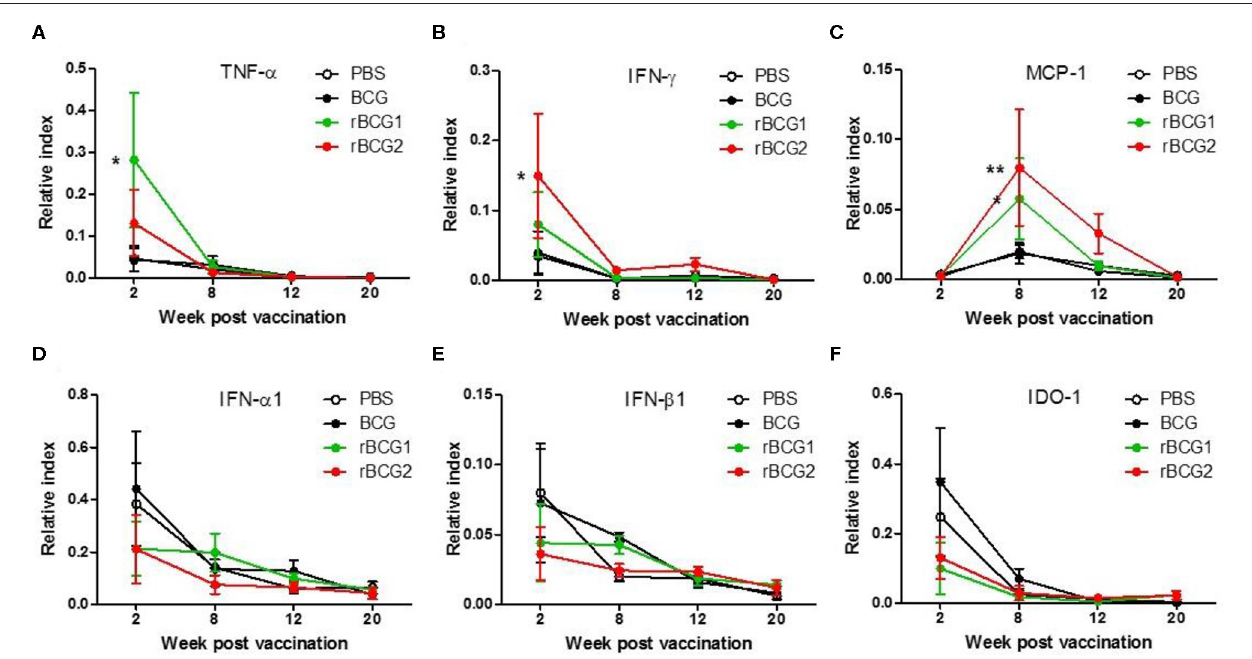
FIGURE 3 | Th1-mediated cytokine profiles expressed in murine lung following immunization with rBCG1 or rBCG2. C57BL/6 mice were immunized with BCG, rBCG1 or rBCG2 at weeks 0 and 2. They were then challenged with H37Ra at week 4 ( n = 6–7, in two independent experiments). At 2, 8, 12, and 20 weeks, the mice were sacrificed, lung RNA was extracted and cytokine gene expression profiles were determined using qPCR. (A) TNF- α , (B) IFN- γ , (C) MCP-1, (D) IFN- α 1, (E) IFN- β 1, (F) IDO-1. Differences among groups were determined using two-way ANOVA with a Bonferroni post hoc test (* P < 0.05; ** P <